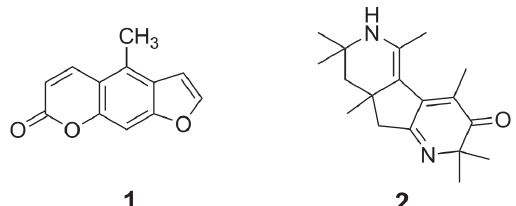
FIGURE 1 - Structures of internal standard ( 1 ) and olera- cimine ( 2